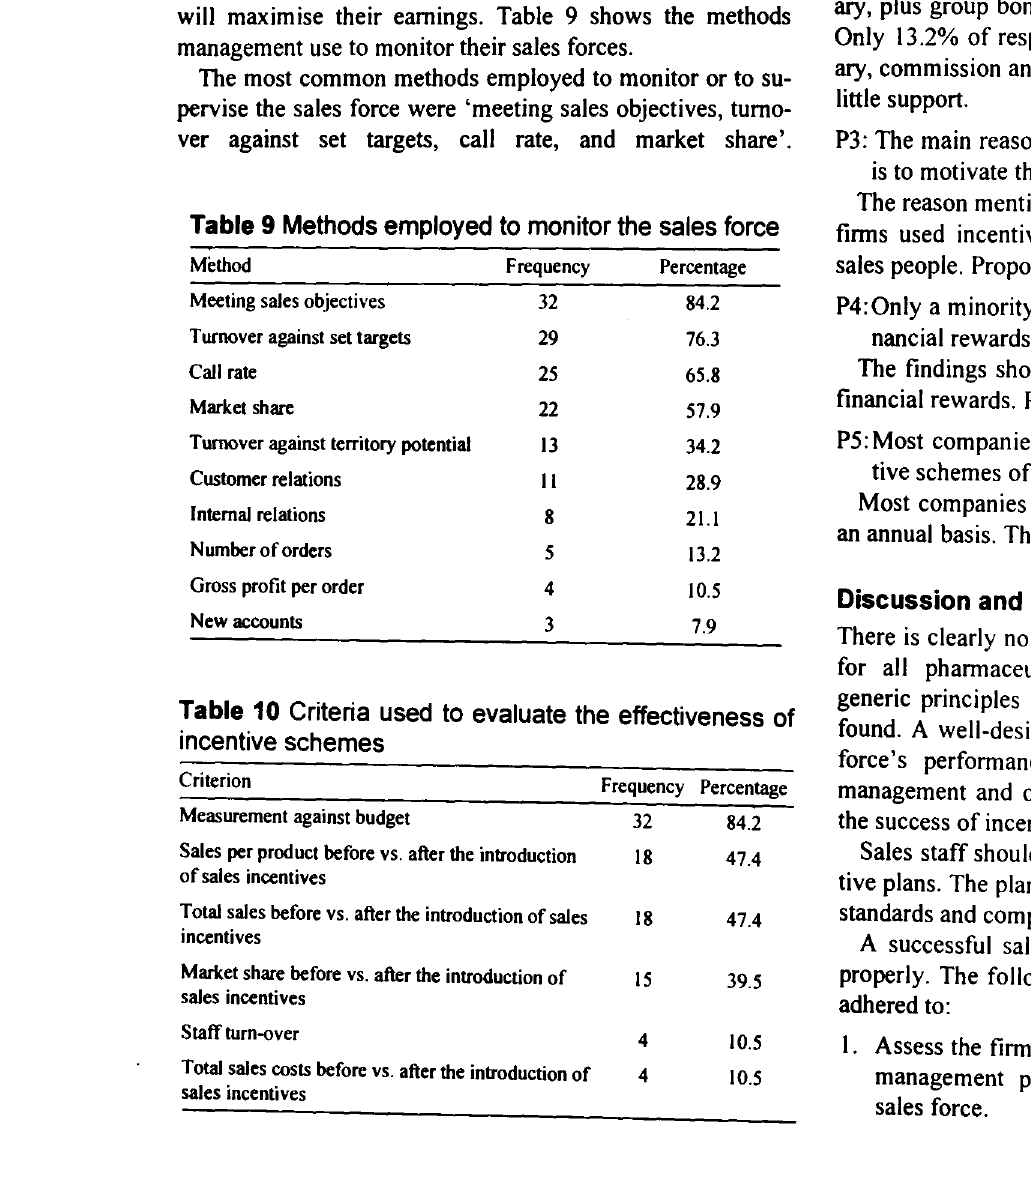
Table 10 Criteria used to evaluate the effectiveness